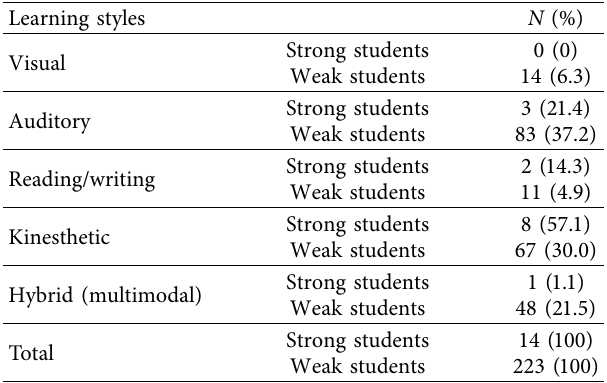
Table 2: Frequency distribution of learning styles among